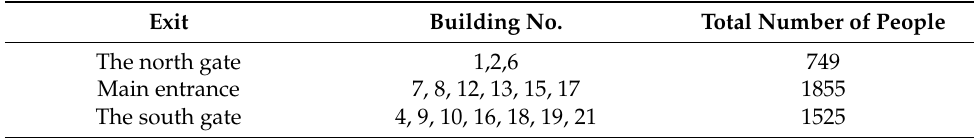
Figure 3. Building map and exit marker. The blue rectangular area indicates the building number of the evacuees and red lines indicate evacuation routes. Table 1. Evacuation exit allocation table.